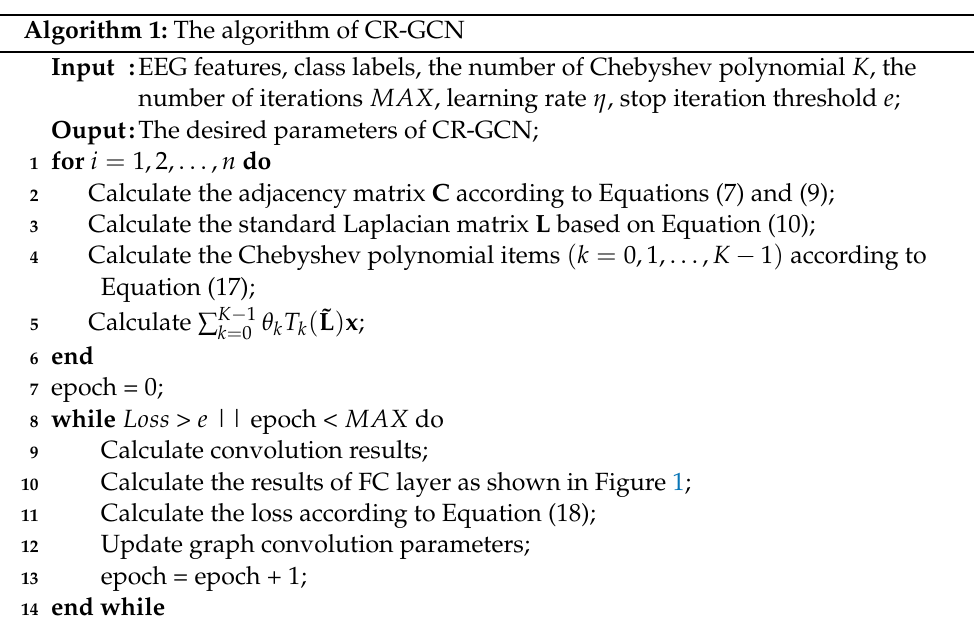
Algorithm 1: The algorithm of CR-GCN